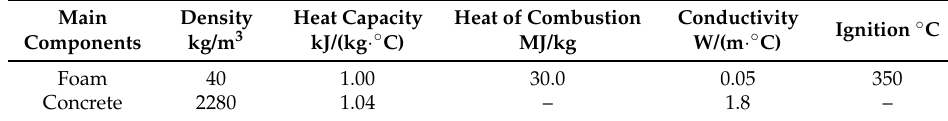
Table 5. Main parameters of components in the model.